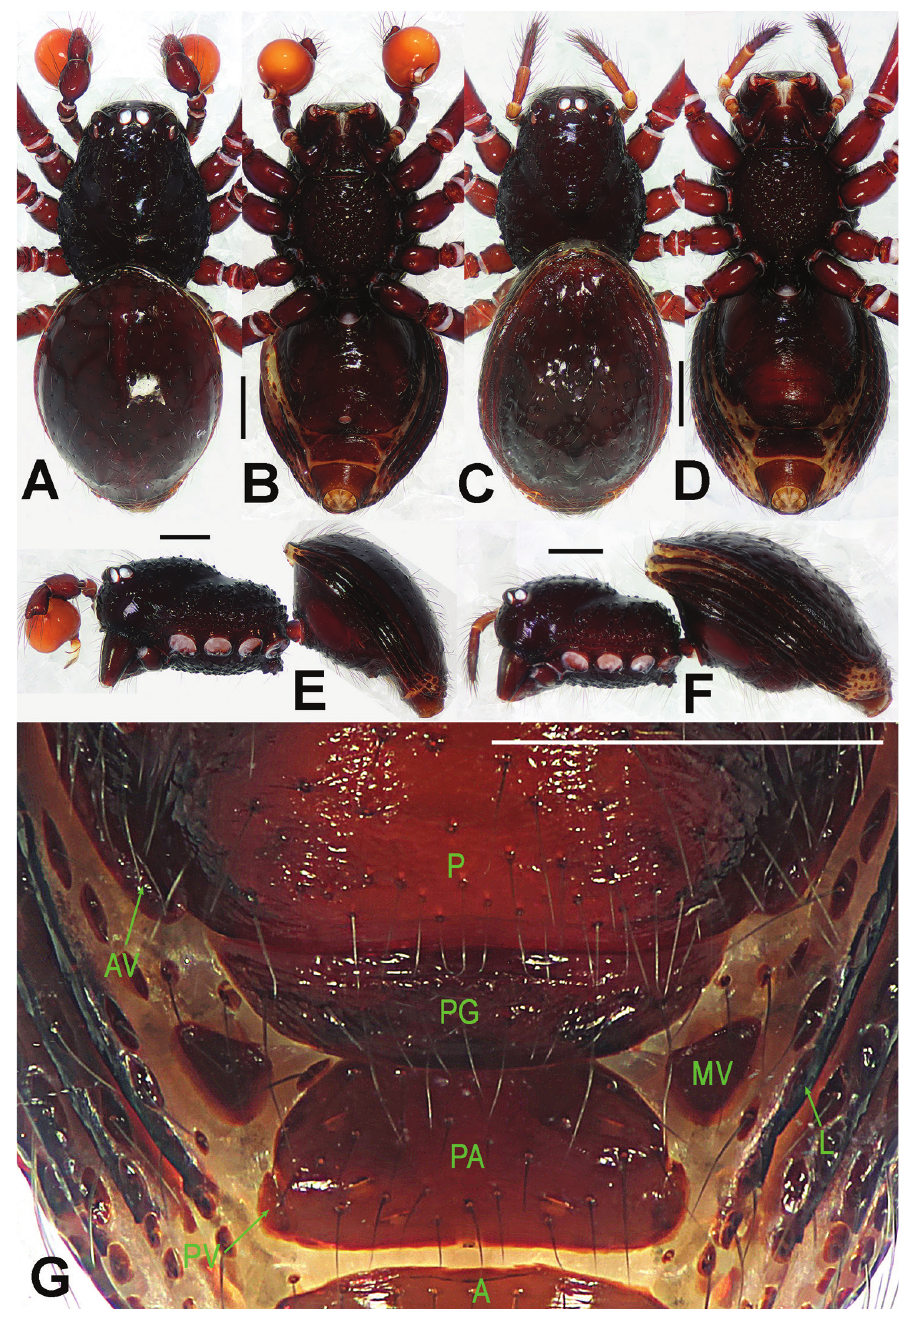
Figure 1. Paculla bukittimahensis sp. n., male holotype ( A–B, E ) and female paratype ( C–D, F–G ). A–F habitus G genital area (untreated). A, C dorsal B, D, G ventral E–F lateral. Abbreviations: A = anal plate; AV = anterior ventrolateral plate; L = lateral plate; P = pulmonary plate; PA = preanal plate; PG = postgenital plate; PV = posterior ventrolateral plate. Scale bars: 0.50